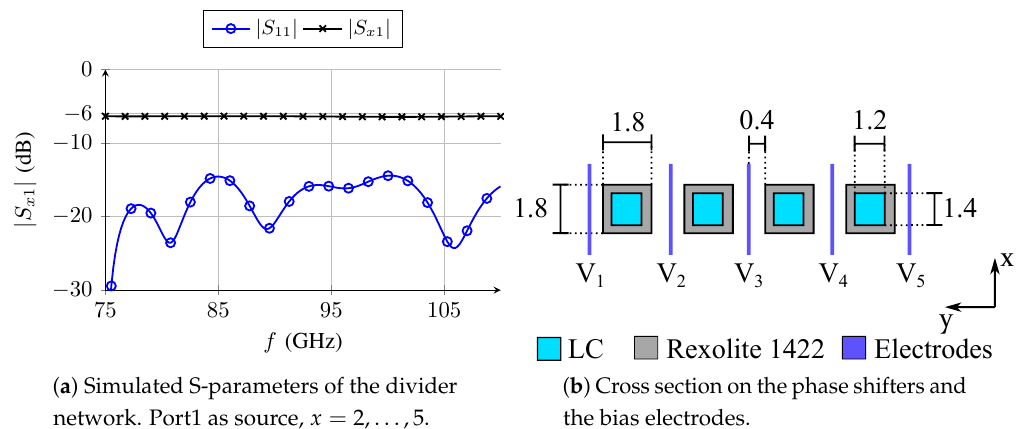
( a ) Simulated S-parameters of the divider ( b ) Cross section on the phase shifters and network. Port1 as source, x = 2, . . . ,5. the bias electrodes. Figure 30. ( a ) Simulation results of the divider network, ( b ) bias structure of the array. For steering, different voltages V 1 to V 5 with respect to a common ground are applied to bias the LC differently in the individual branches. All dimensions given in mm.